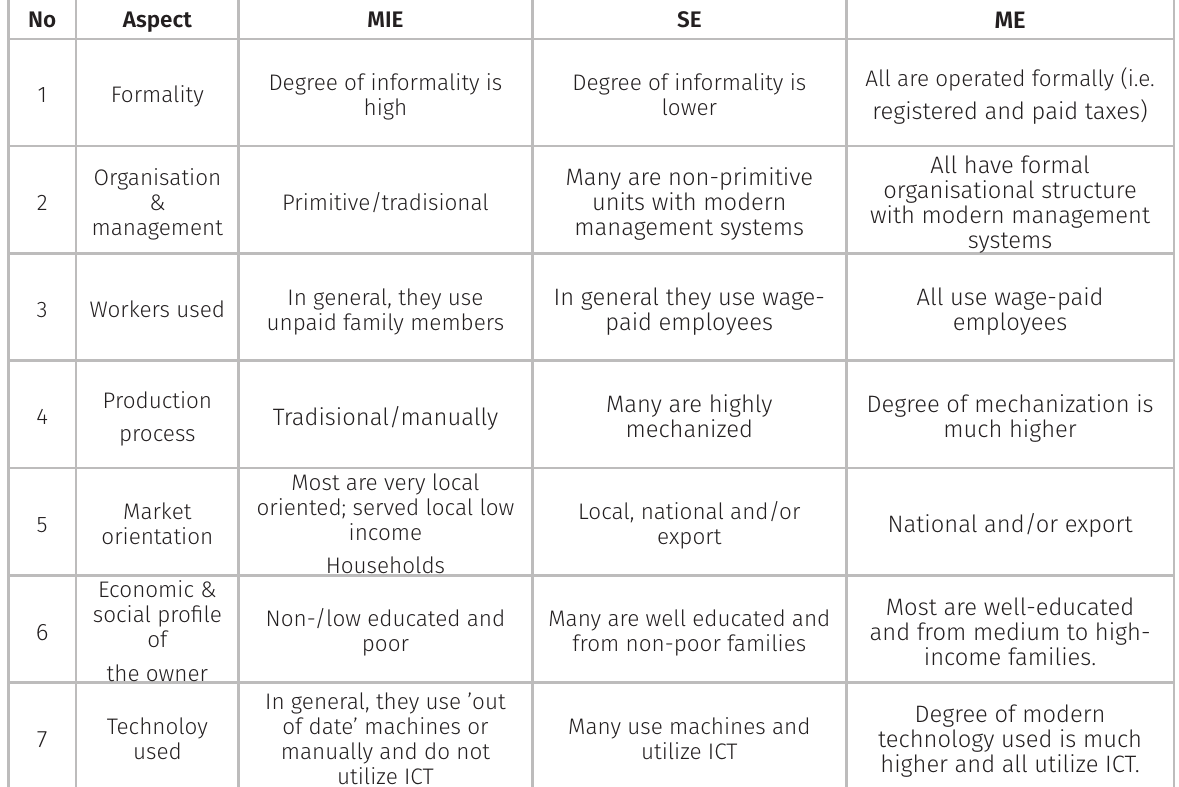
Table I. Key characteristics of MIE, SE, and